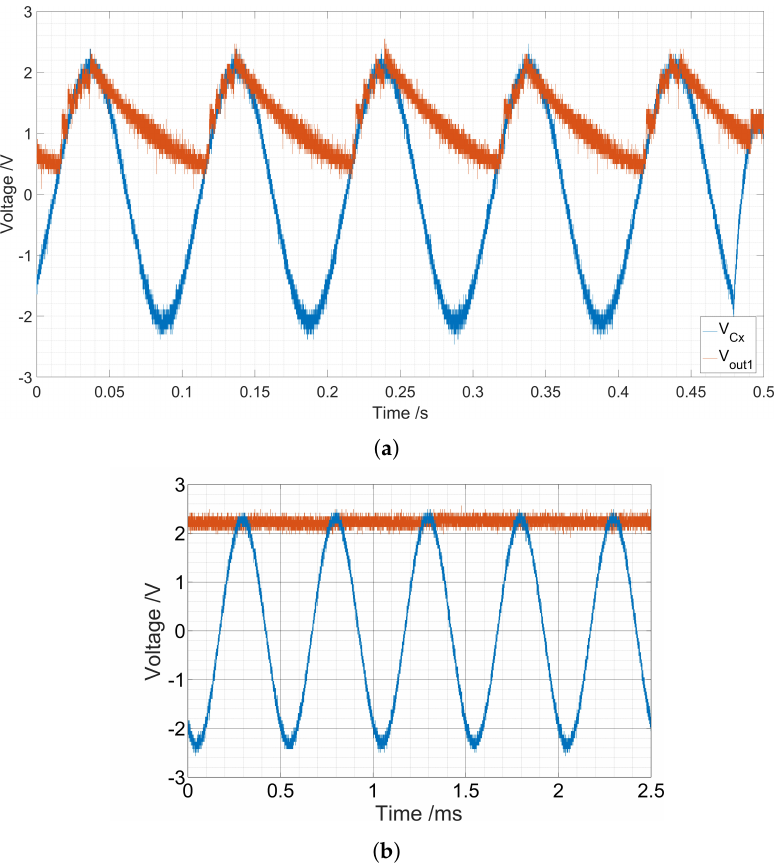
Figure 13. Example of the output of the peak detector at different frequencies where the discharging effect of the capacitor C D is clear. ( a ) The sensor voltage V CX and output of the positive peak detector V out 1 at 10 Hz. ( b ) The sensor voltage V CX and output of the positive peak detector V out 1 at 1